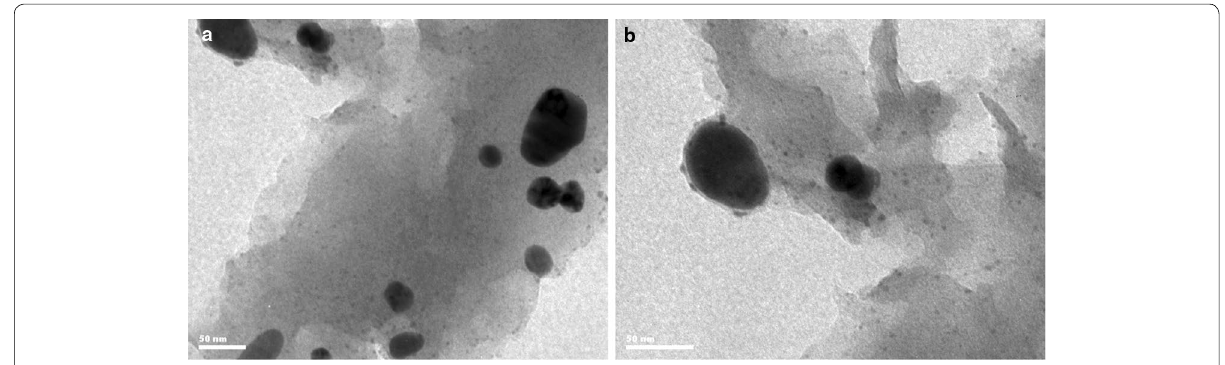
Fig. 4 a , b TEM images of AgNP/RGO nanocomposites